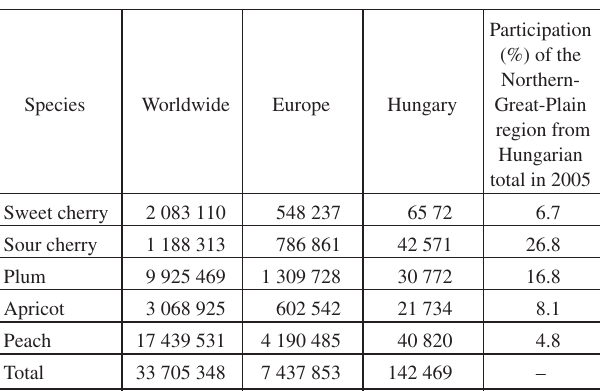
Table 1. Volumes of store-fruits grown in 2007 (t)